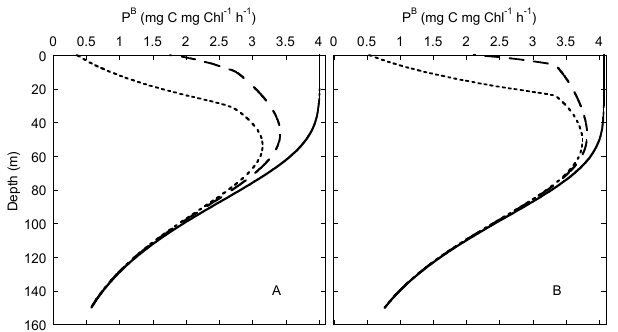
Figure 8. Depth profiles of productivity as predicted using the BWF E /P-E model evaluated with the P-E equation and no in- max hibition (solid line), with only inhibition by PAR ( ε PAR ) included (long dashes) or with full UV+PAR inhibition (short dashes). The curves in (A) show the average response by Synechococcus (ML 20 ◦ cultures, WH8102 and WH7803 combined); in (B) is shown predicted response based on a fit of the BWF E /P-E model to max the photoinhibitron data for the diatom Thalassiosira pseudonana (strain 3H) grown at comparable growth irradiance and temperature (from Sobrino et al.,